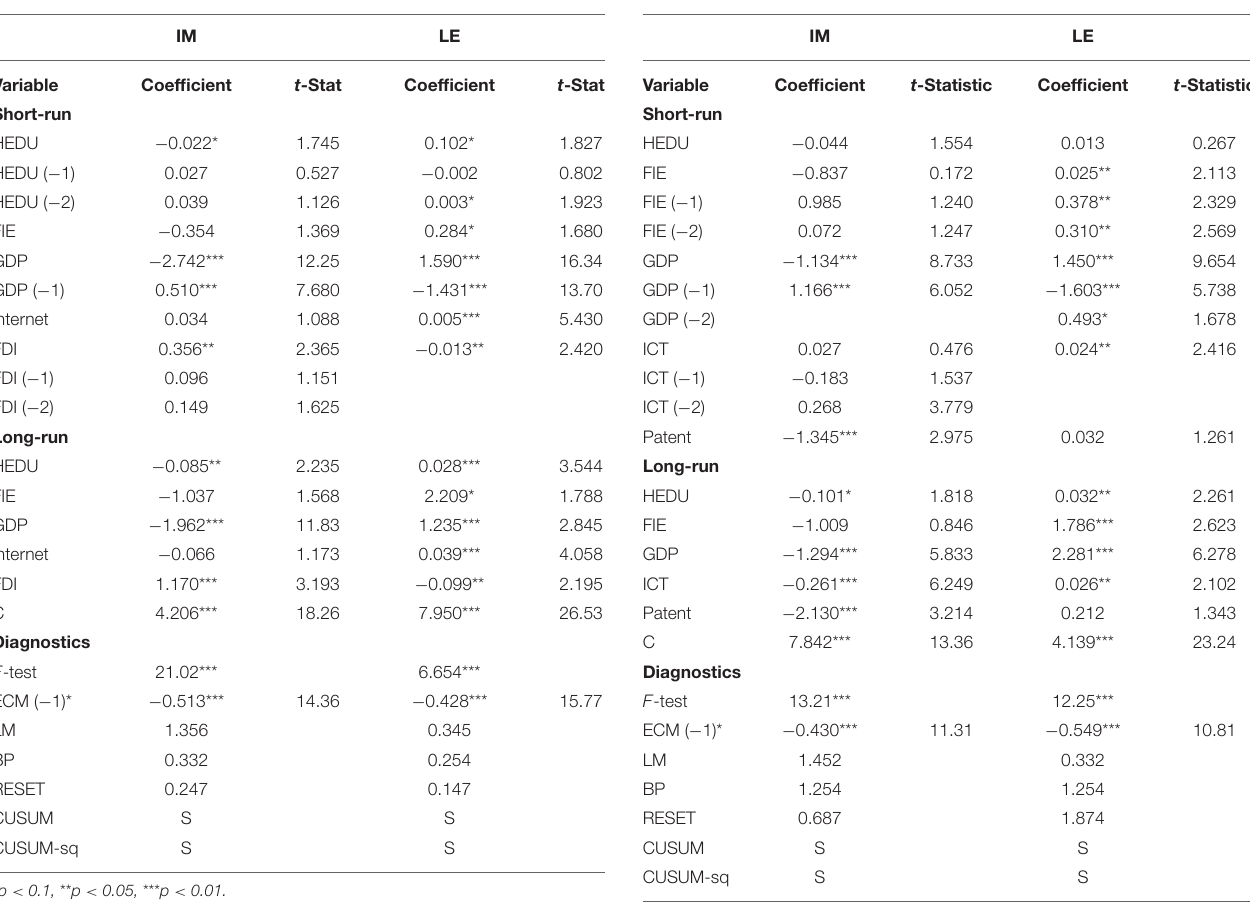
TABLE 3 | ARDL estimates of human health. TABLE 4 | ARDL estimates of human health